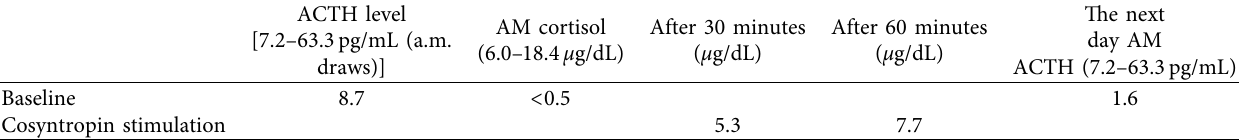
Table 1: Initial admission cosyntropin stimulation